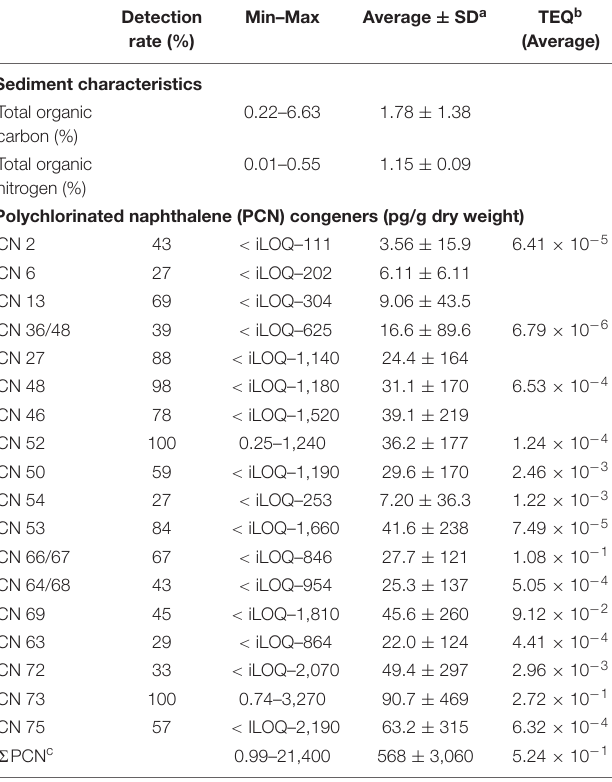
TABLE 1 | Sediment characteristics and the concentrations of polychlorinated naphthalene (PCN) congeners in sediments collected from Ulsan and Onsan Bays and their inflowing streams and rivers,